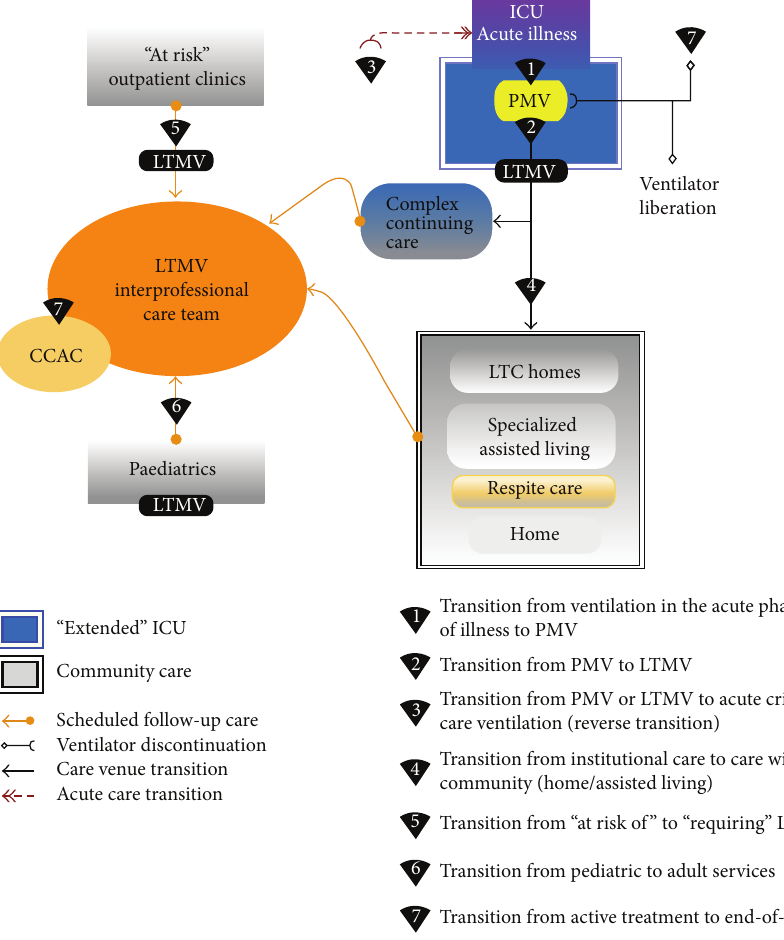
Figure 2: Systems model for care transitions and planned